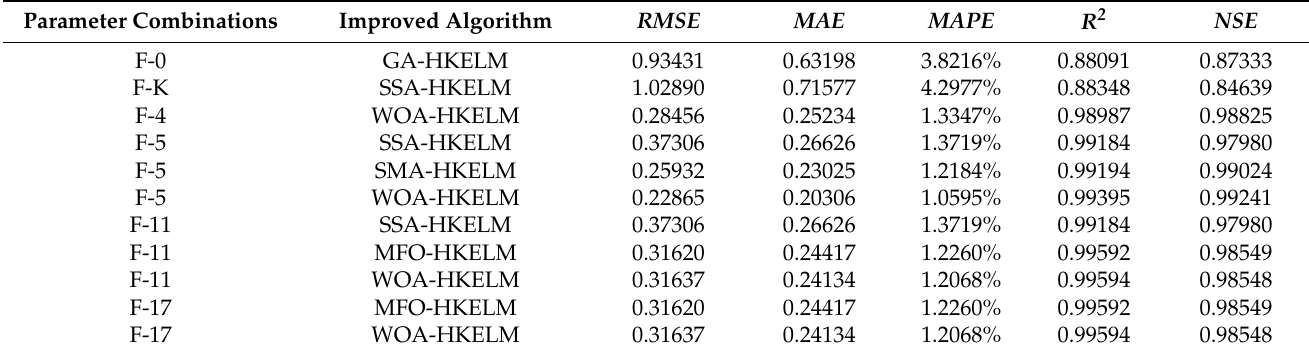
Table 4. Parameter combination and prediction algorithm fusion model results.